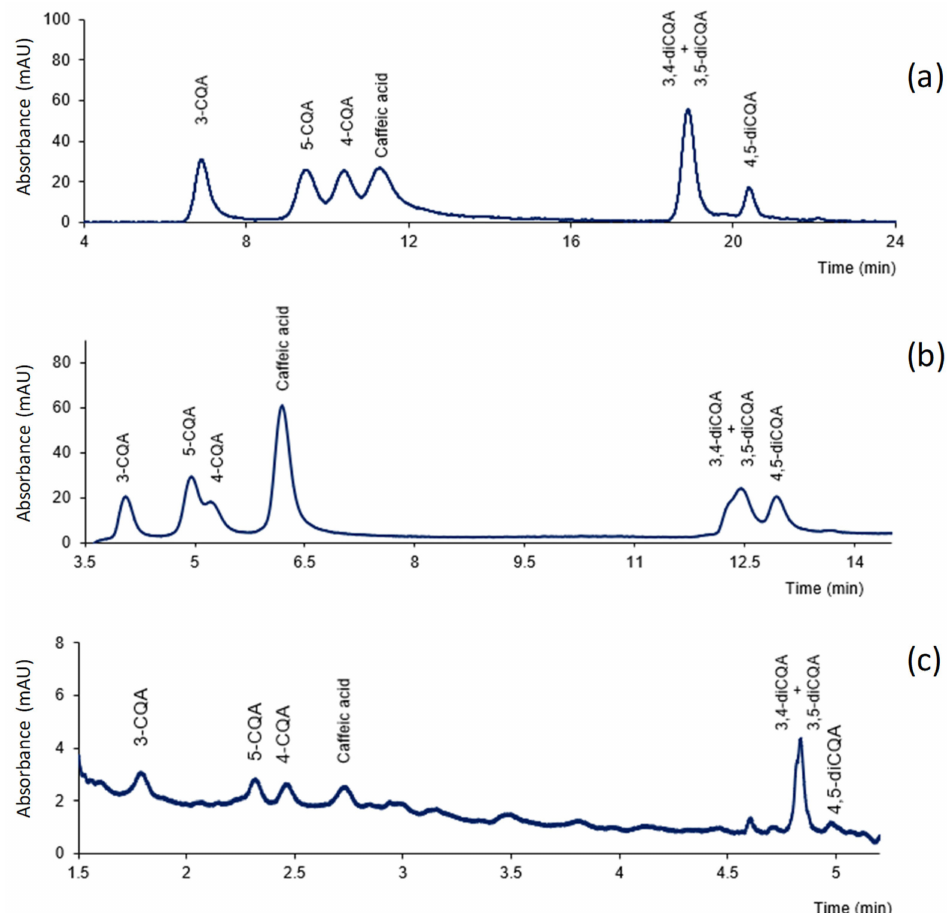
Figure 1. Chromatograms obtained for standard mixtures of caffeic acid and CGAs under the proposed conditions: ( a ) chromatogram obtained at 330 nm for a solution containing 1 µ g mL − 1 of each compound with the capLC system; ( b ) chromatogram obtained at 330 nm for a solution containing 0.5 µ g mL − 1 of each compound with the benchtop nanoLC system; ( c ) chromatogram obtained at 255 nm for a solution containing 60 µ g mL − 1 with the portable LC system. For other experimental details, see